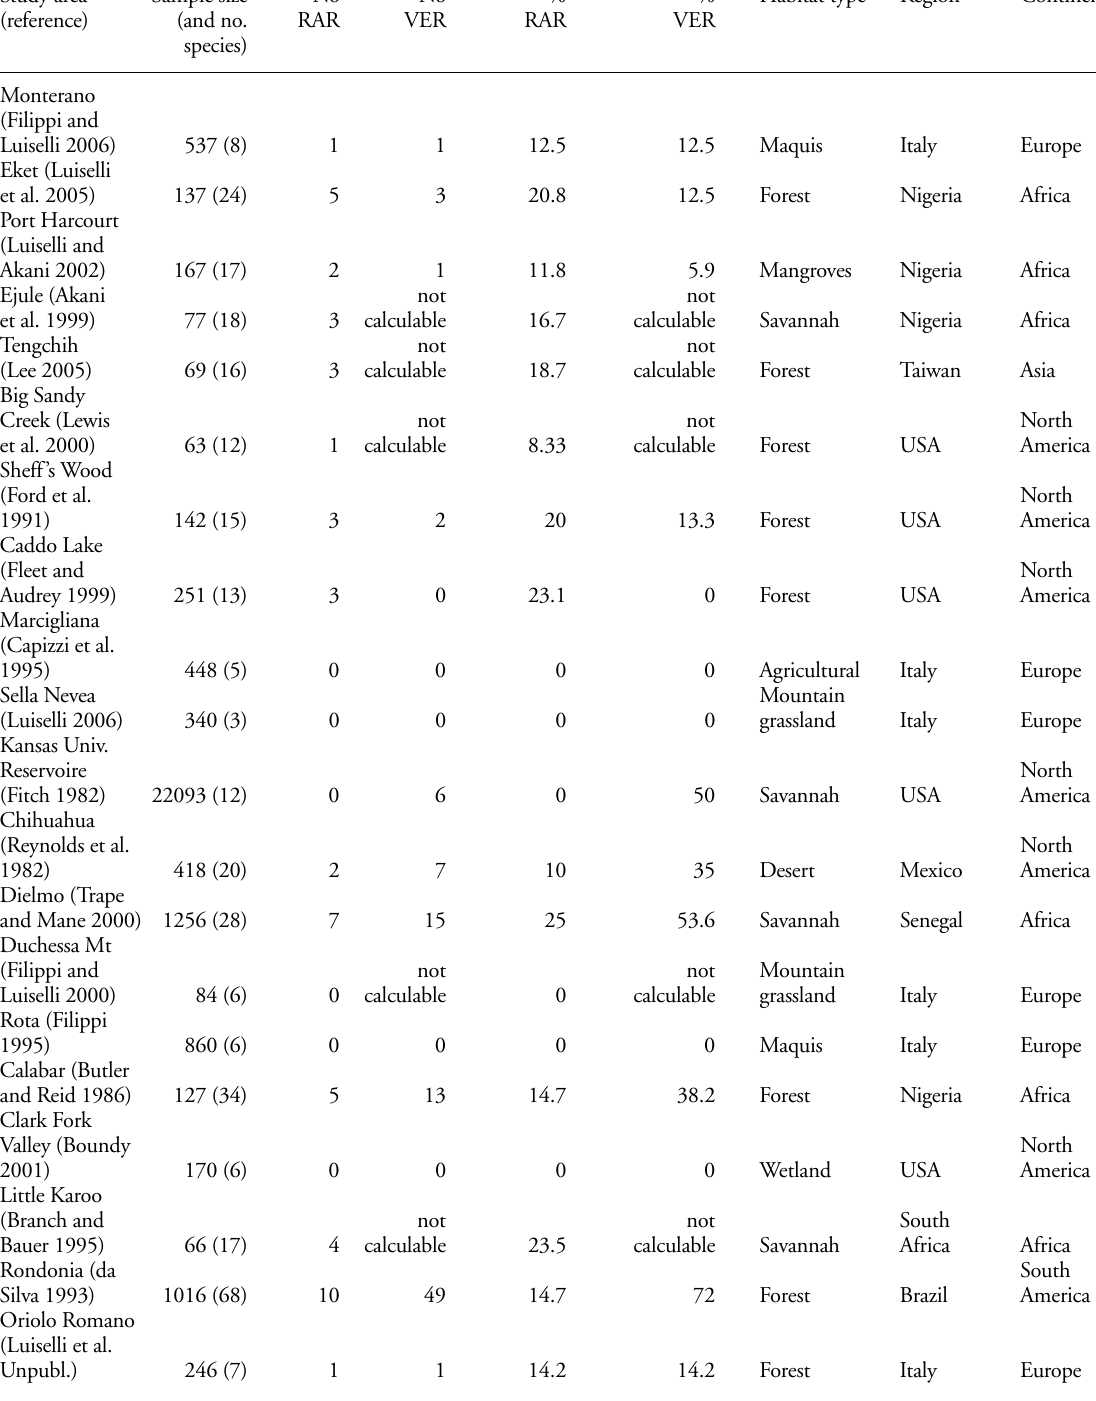
Table 1. Summarized dataset used for this study, including study area, sample sizes, number and relative percentage of rare (RAR) and very rare (VER) species, habitat type, country, continent, and pertinent literature entry. Note that habitat types are simplified for allowing comparisons between areas; for instance, all prairie-like grasslands are considered ‘savannah’, all types of swamped areas are considered ‘wetlands’,